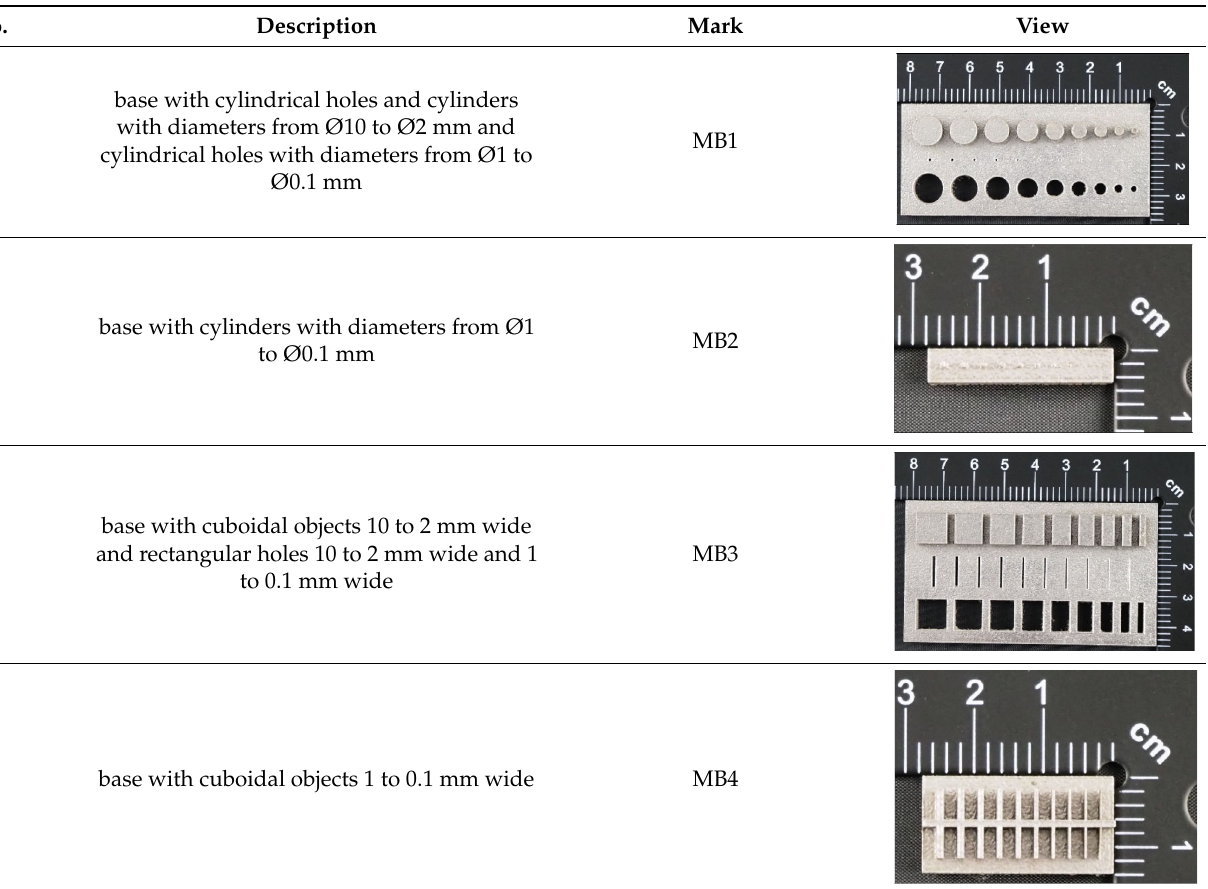
Table 4. Research